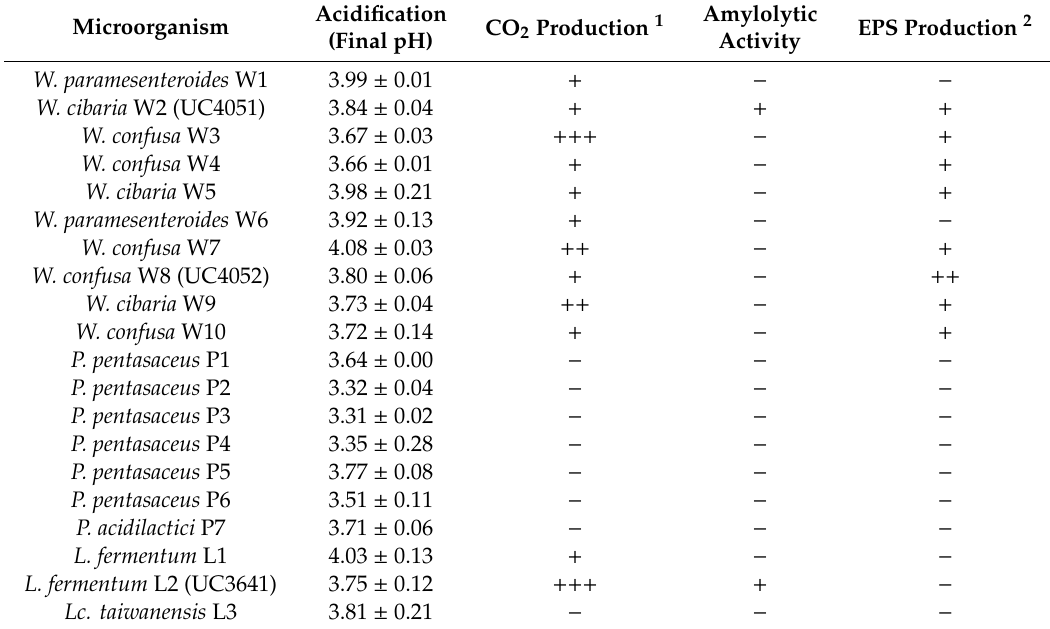
Table 1. Results of the phenotypic characterization of LAB isolated from sorghum